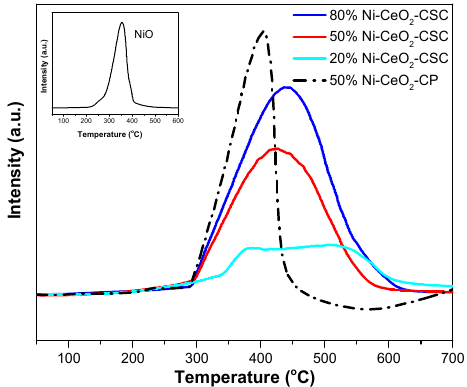
Figure 4. H 2 programmed temperature reduction profiles of the NiO, the 50% Ni-CeO 2 -CP and the Ni-CeO 2 -CSC.